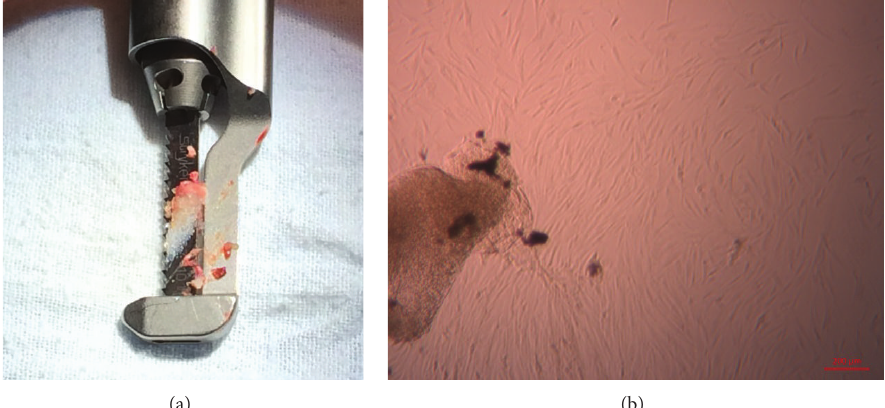
Figure 1: Discarded neonatal sternal tissue contains MSCs. (a) Sternotomy saw blade with sternal tissue during neonatal cardiac surgery. (b) Plastic-adherent MSCs migrating from sternal tissue after 14 days. Scale bar = 100 𝜇